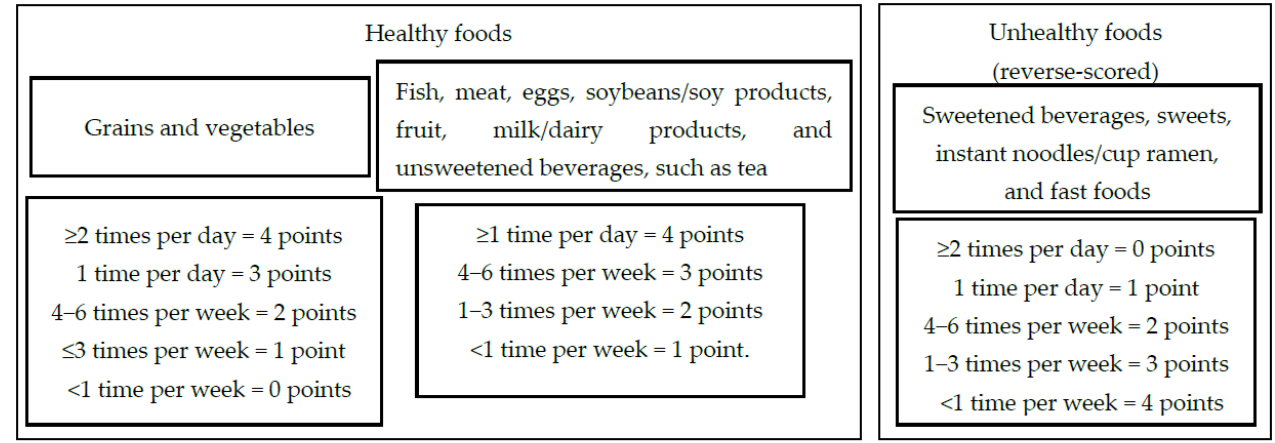
Figure 1. Calculating the healthy diet score